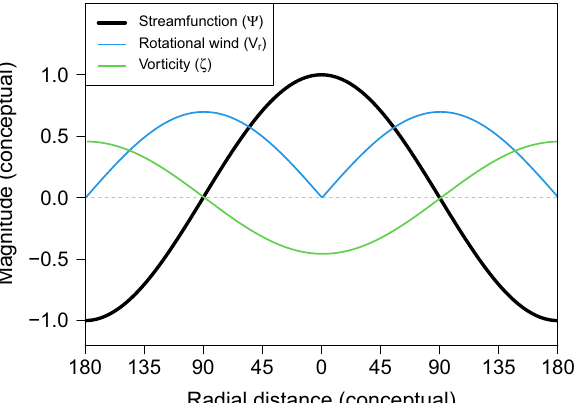
Figure 2. Funcionality of streamfunction. The schematic shows the interrelationship among streamfunction ( ψ ), rotational wind ( V r ), and vorticity ( ζ ) using a one-dimensional distribution of ψ . The distribution of ψ follows a sine curve for example. V r is defined by the gradient of ψ , and ζ is formed by the gradient of V r . From the Laplacian, ψ is negatively proportional to ζ , and represents a large-scale pattern of ζ . The value on the x-axis conceptually represents the radial distance from the ψ ’s maximum. For comparison in the same plot, V r and ζ are 40 and 1500 times multiplied,